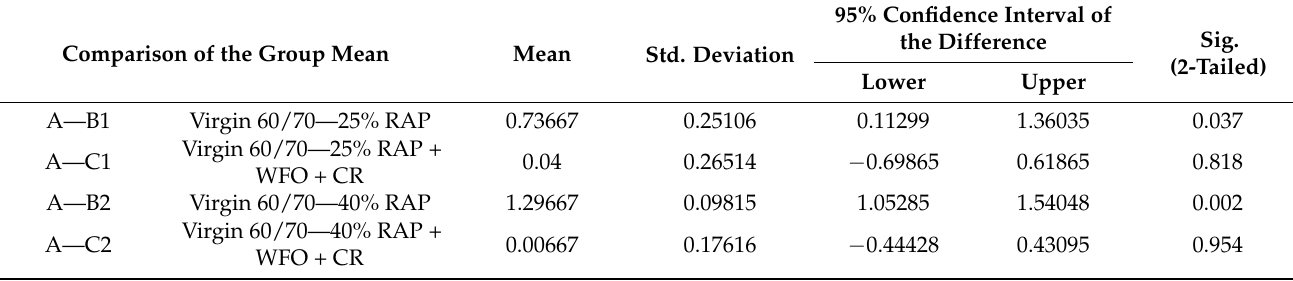
Table 19. The significant difference in the group means for the rutting of the virgin asphalt with RAP and the recycled asphalt mixture at 45 ◦ C. Comparison of the Group Mean Mean Std. Deviation